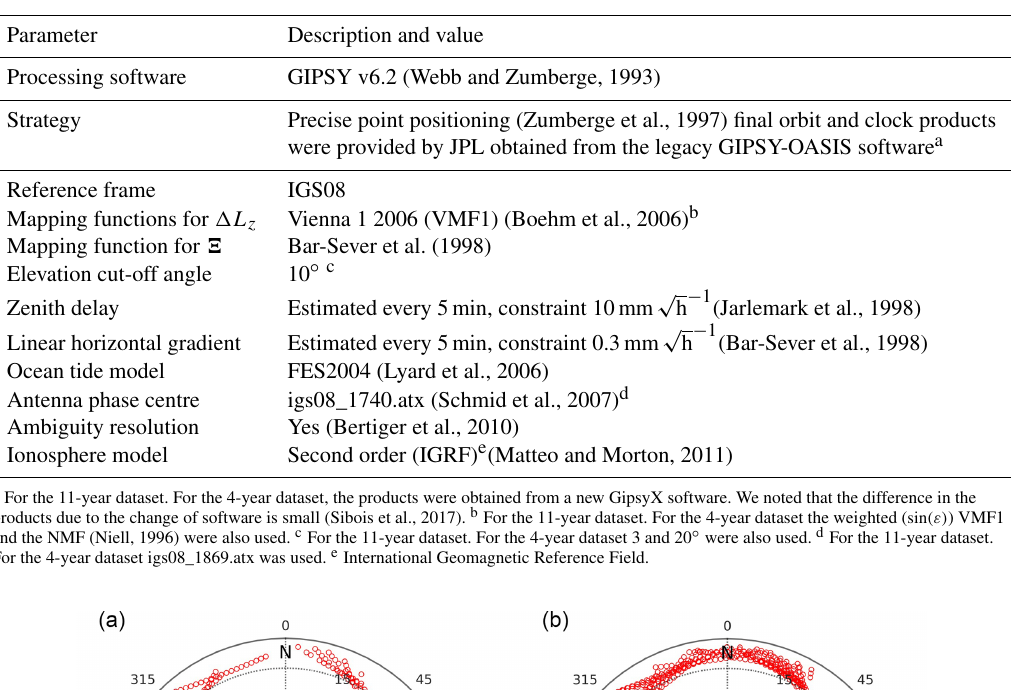
Table 1. Processing of GPS data.